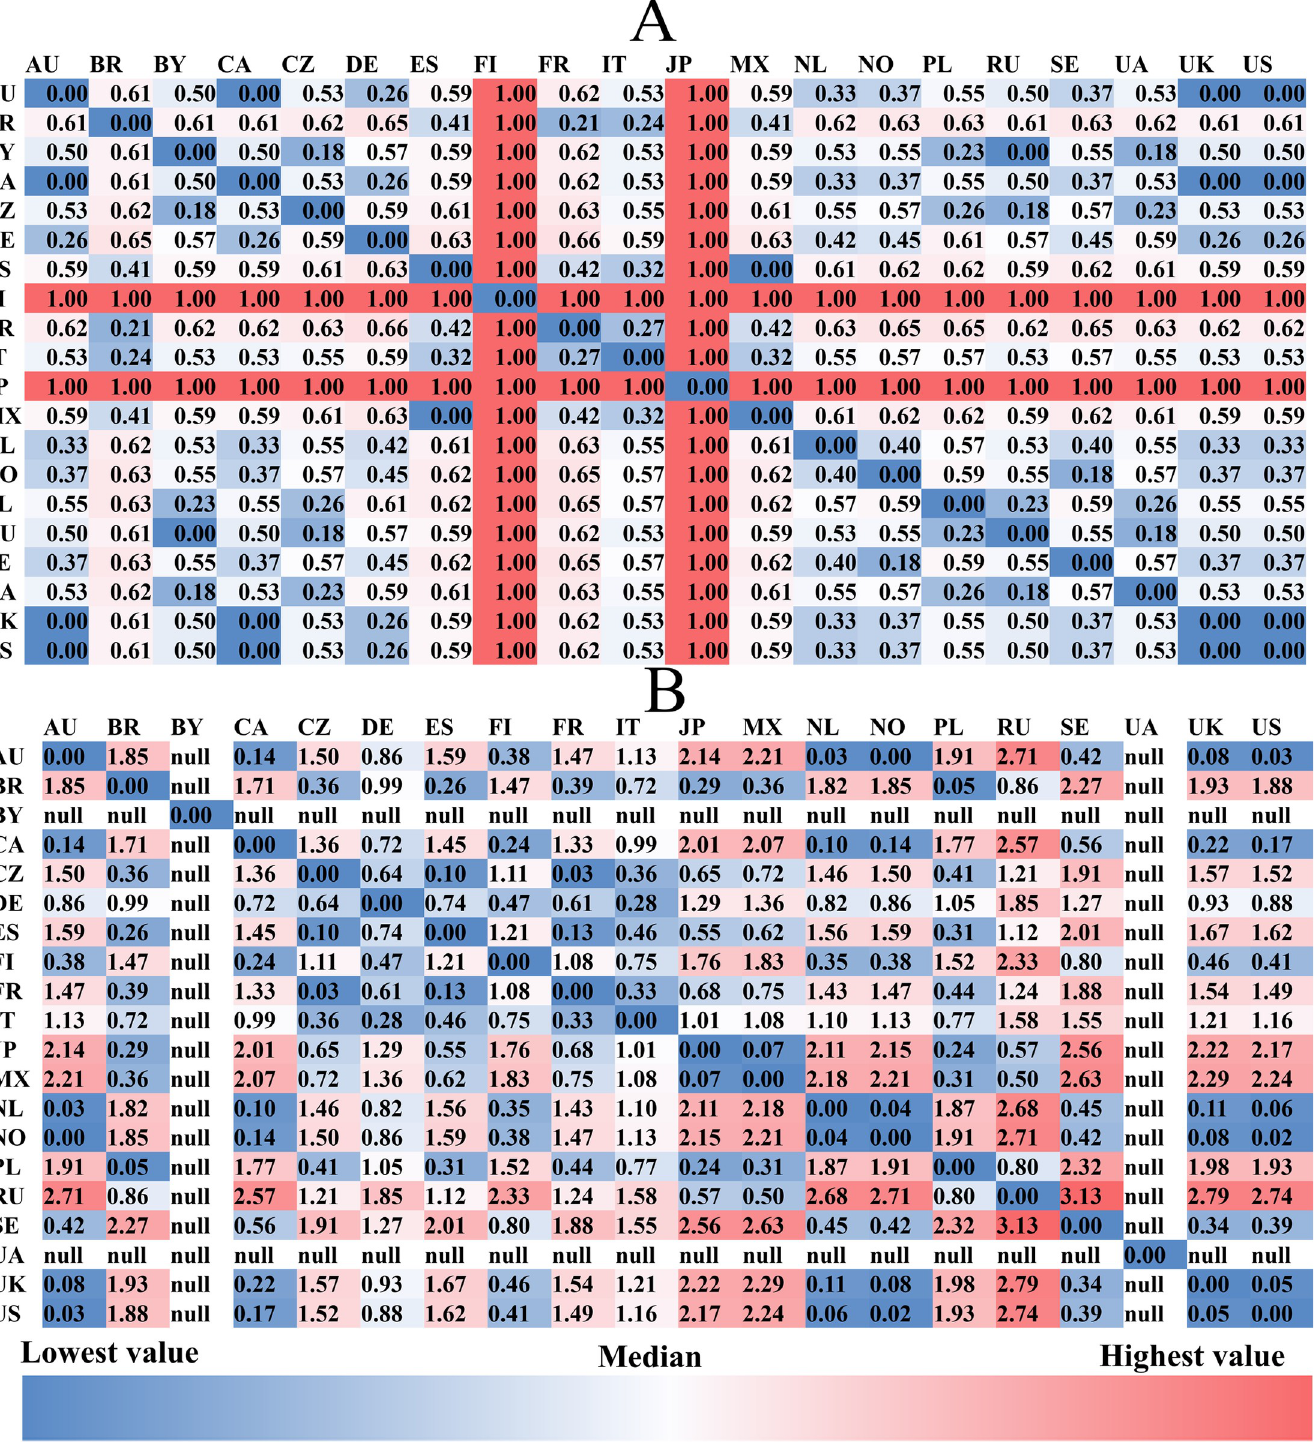
PLOS ONE | https://doi.org/10.1371/journal.pone.0208186 December14,